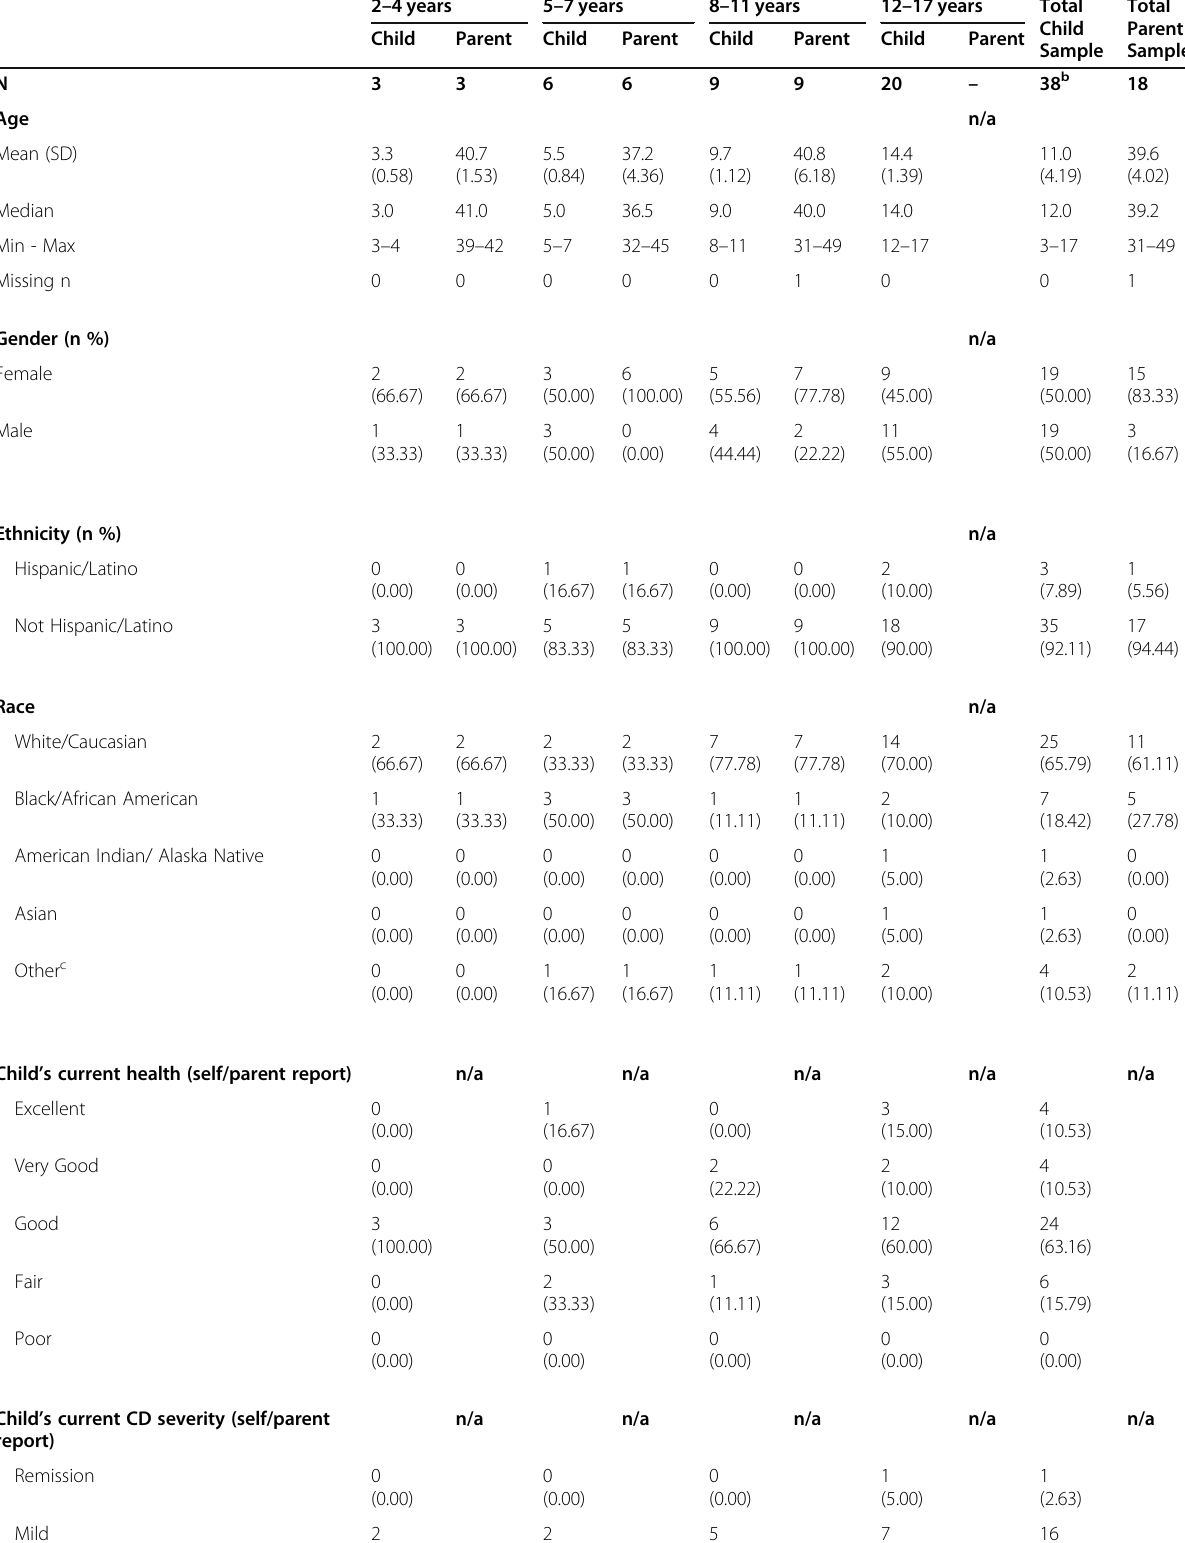
Table 1 Demographic Characteristics of Children and Parent Participants